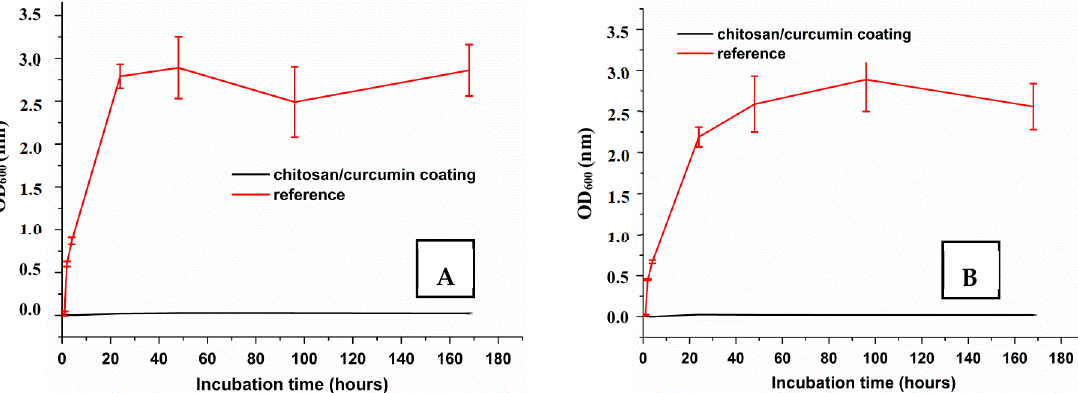
Figure 11. Antibacterial susceptibility test, showing the effect of chitosan/curcumin coatings on PEEK / BG / h-BN layers for Gram-positive ( A ) and Gram-negative ( B ) bacteria over the incubation period of 1 week (The error bars indicate ( ± ) standard deviation for three individual experiments, and each experiment contain 10 samples, n = 30).